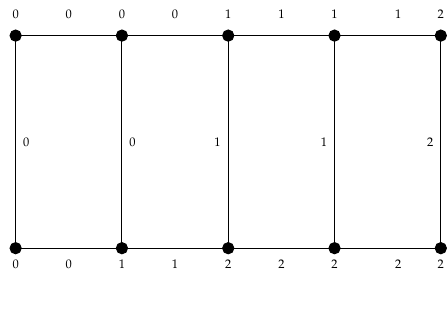
Figure 8. 3-TEMC labeling of L 5